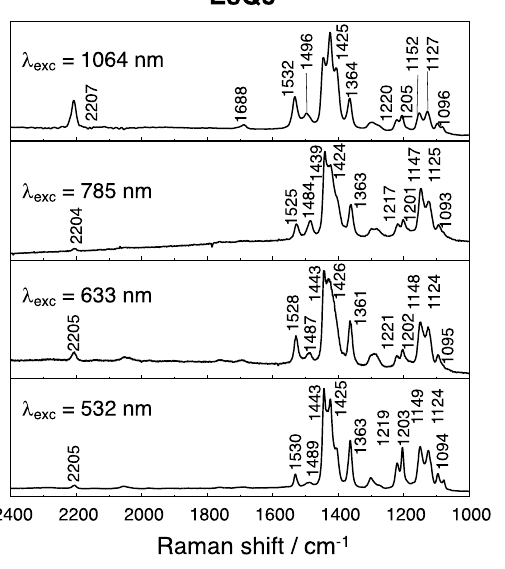
The HR parameters computed for the optically active transition of EsQ3 (Table 3) suggest resonance Raman enhancement not only for the mode dominated by the ECC coordinate at 1447 cm − 1 , but also for vibrations in the 1090–1230 cm − 1 region (Figure S16), in nice agreement with the intensity increase observed for the Raman spectrum measured